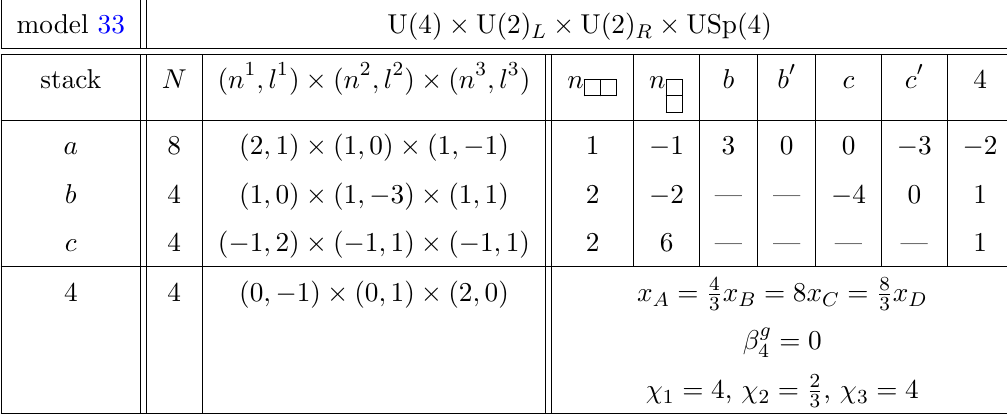
Table 33 . D6-brane configurations and intersection numbers of Model 33, and its MSSM gauge